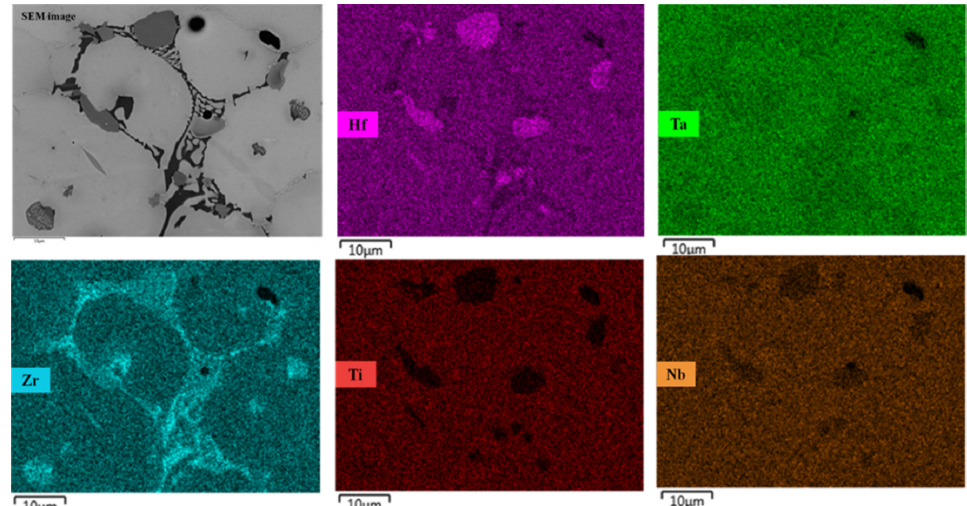
Figure 2. Representative compositional EDX mapping results for the HfTaTiNbZr sample consolidated at 1300 °C ( τ = 0 min).